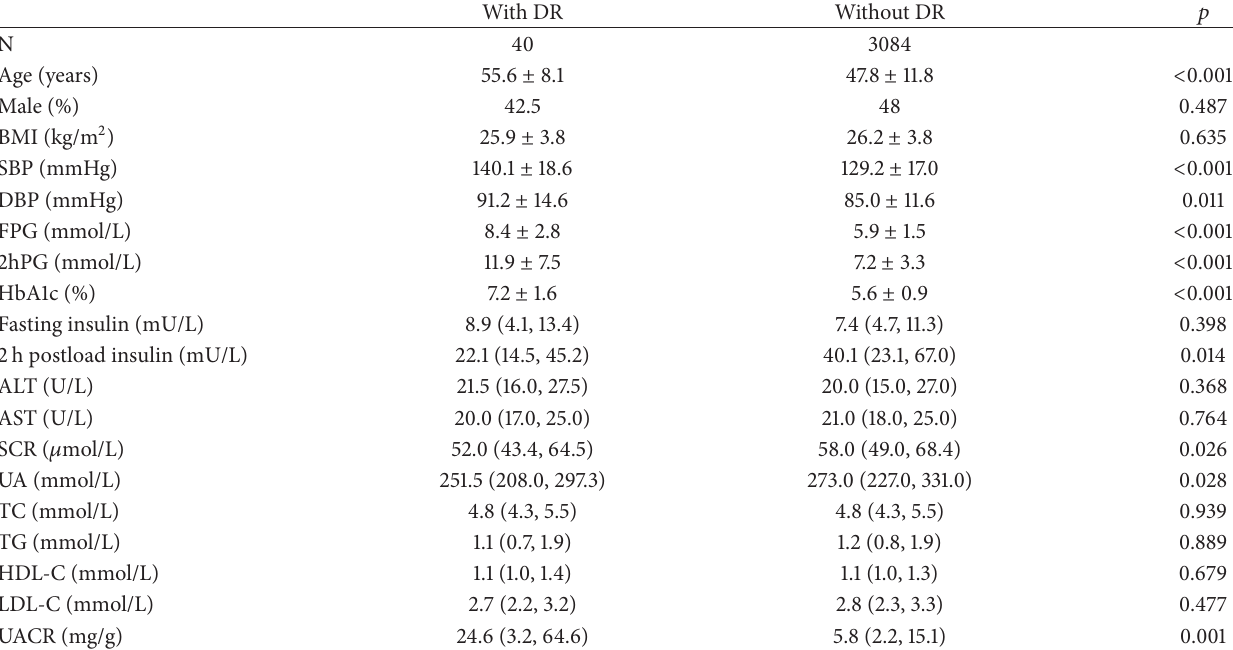
Table 1: Characteristics of the participants divided according to the presence of DR (ETDRS scale score ≥ level 20).